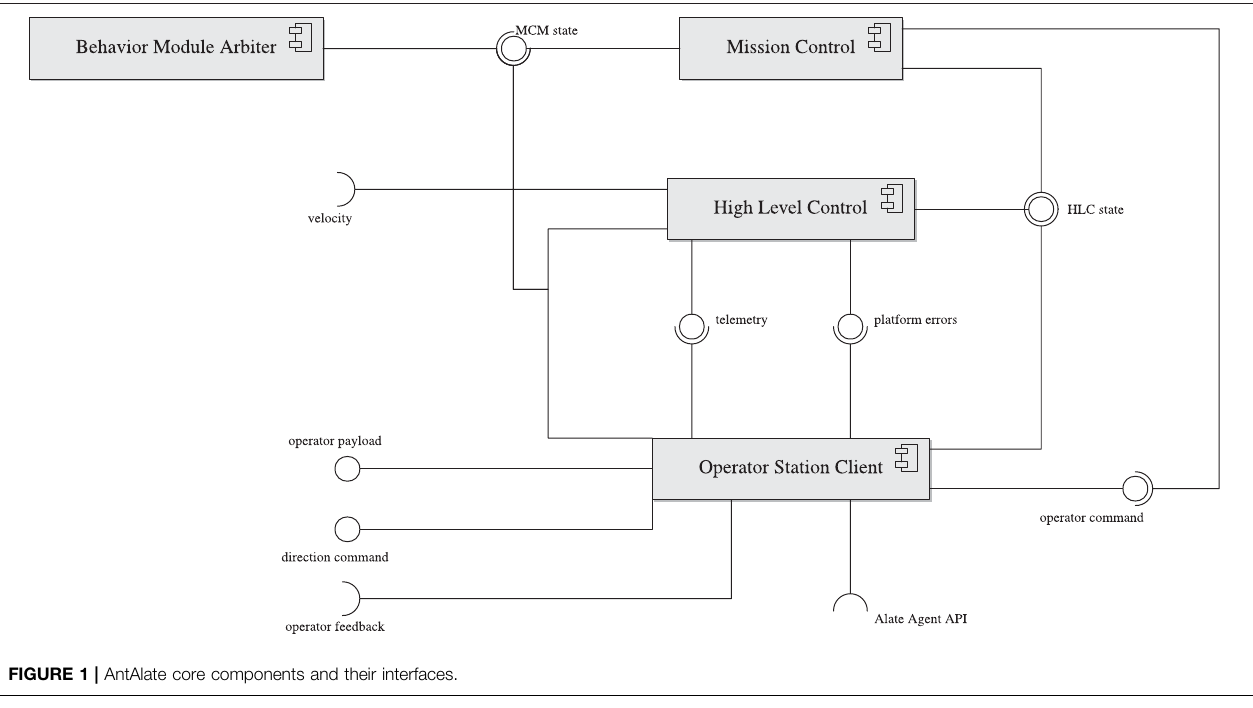
FIGURE 1 | AntAlate core components and their interfaces.